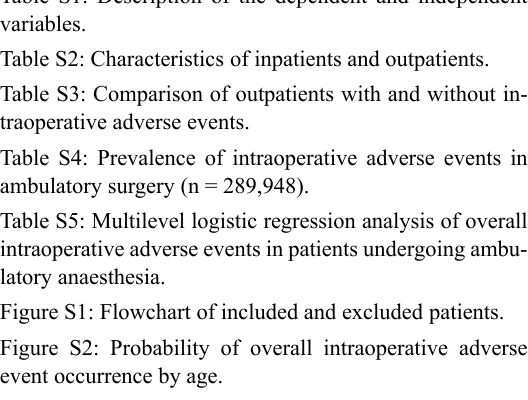
Figure S3: Probability of overall intraoperative adverse event occurrence by gender. Figure S4: Probability of overall intraoperative adverse event occurrence by ASA (American Society of Anesthe- siologists) score. Figure S5: Probability of overall intraoperative adverse event occurrence by comorbidity. Figure S6: Probability of overall intraoperative adverse event occurrence by emergency status. Figure S7: Probability of overall intraoperative adverse event occurrence by anaesthesia type. Figure S8: Probability of overall intraoperative adverse event occurrence by surgical procedure